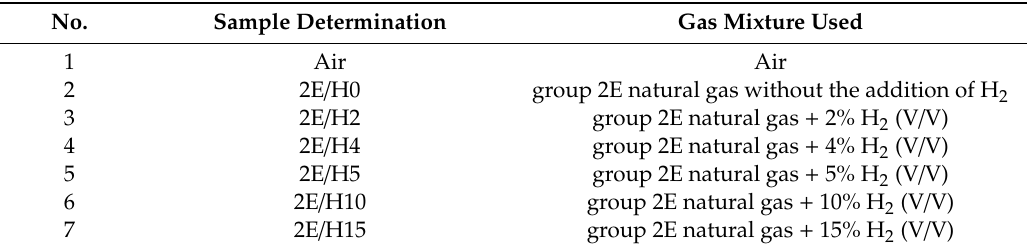
Table 1. Study variants for di ff erent gas